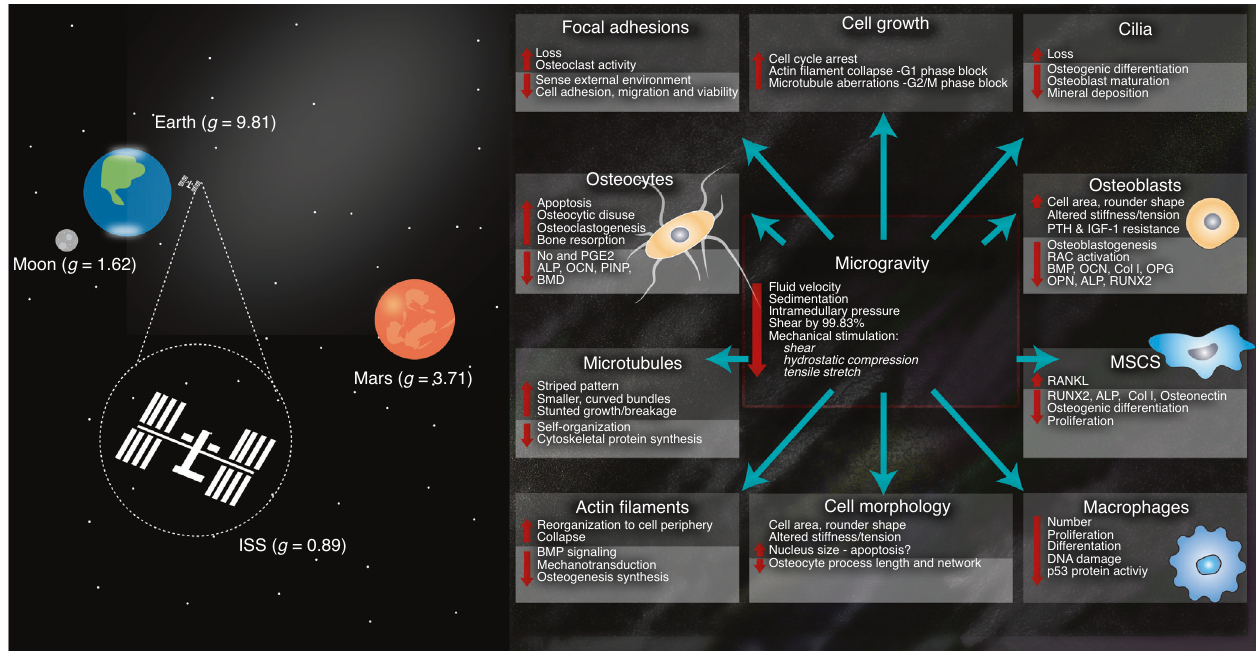
Fig. 5 The effect of microgravity on fl uid fl ow within bone and the subsequent cell response reported in the literature. Bone tissue is a complex mechanical environment that provides a specialized habitat for numerous mechanosensitive cell